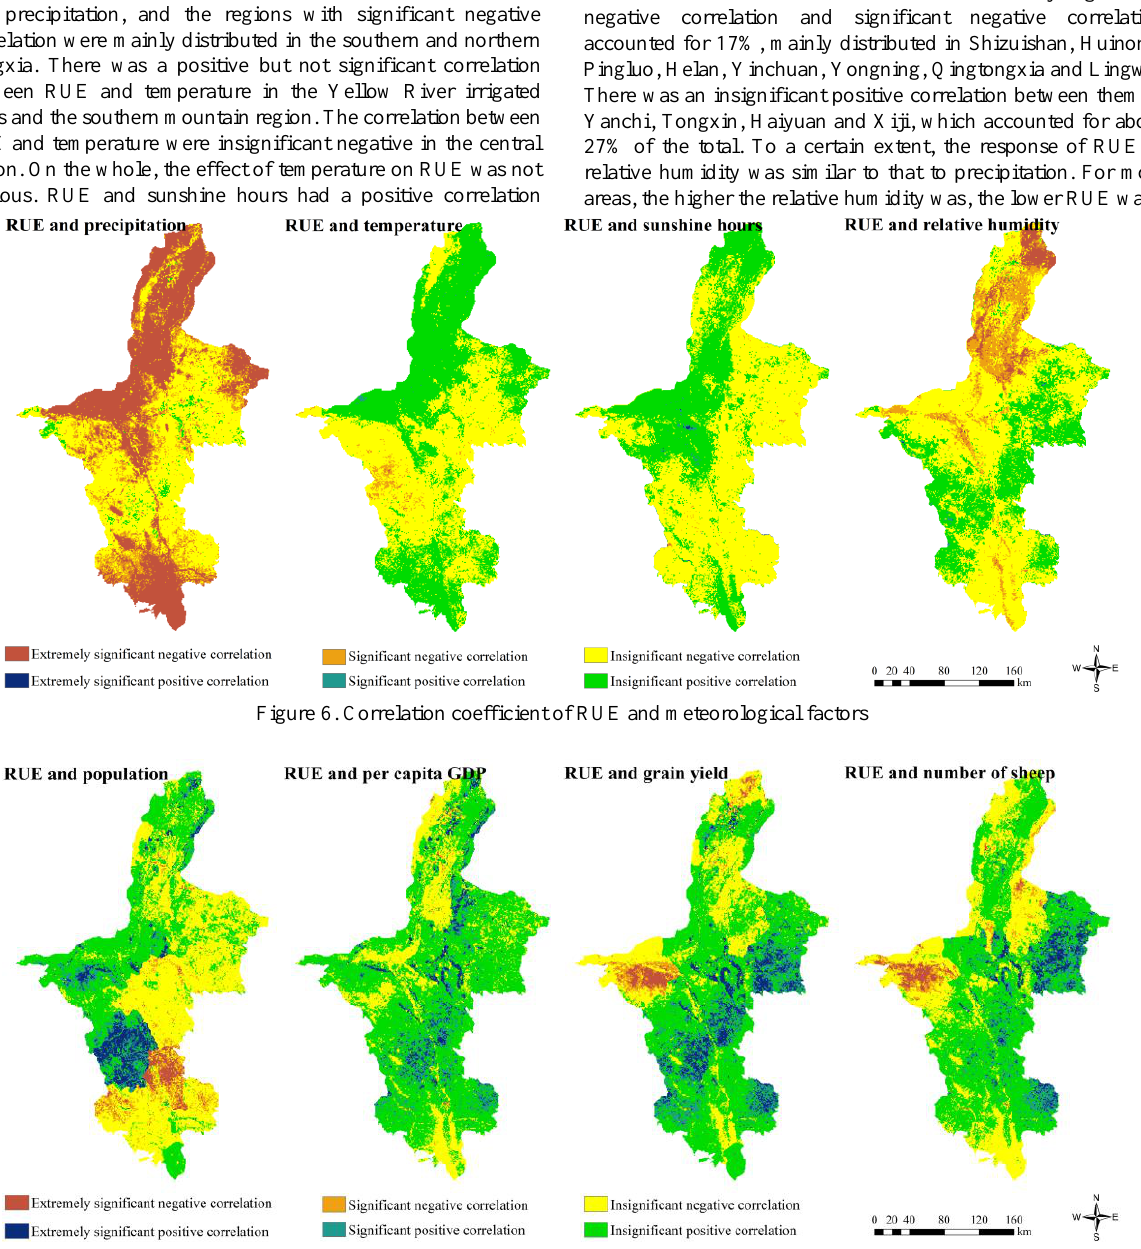
(Figure 6) in Longde, Jingyuan, Shizuishan, Huinong, Pingluo,